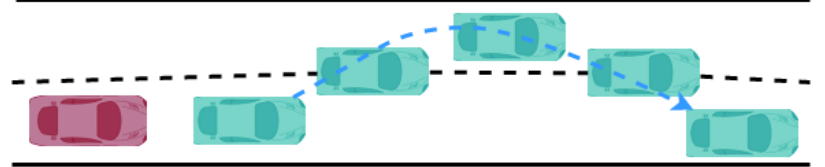
Figure 16. Test Figure 16. Test Scene.